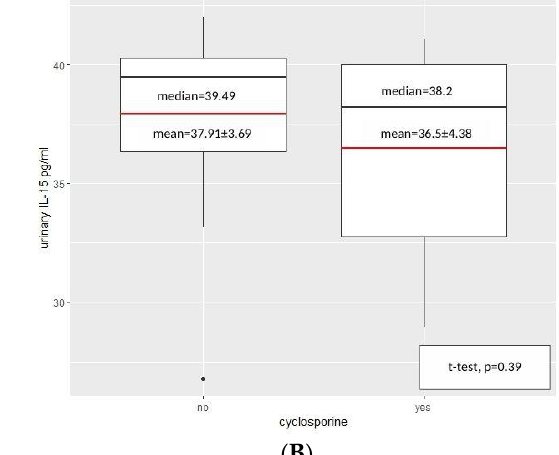
Figure 3. Correlations between the concentration of IL-15 in the serum and urine, considering the division into the study group and the control group (R-Pearson’s correlation coefficient). The test probability of both correlations is higher than the adopted significance level α = 0.05).